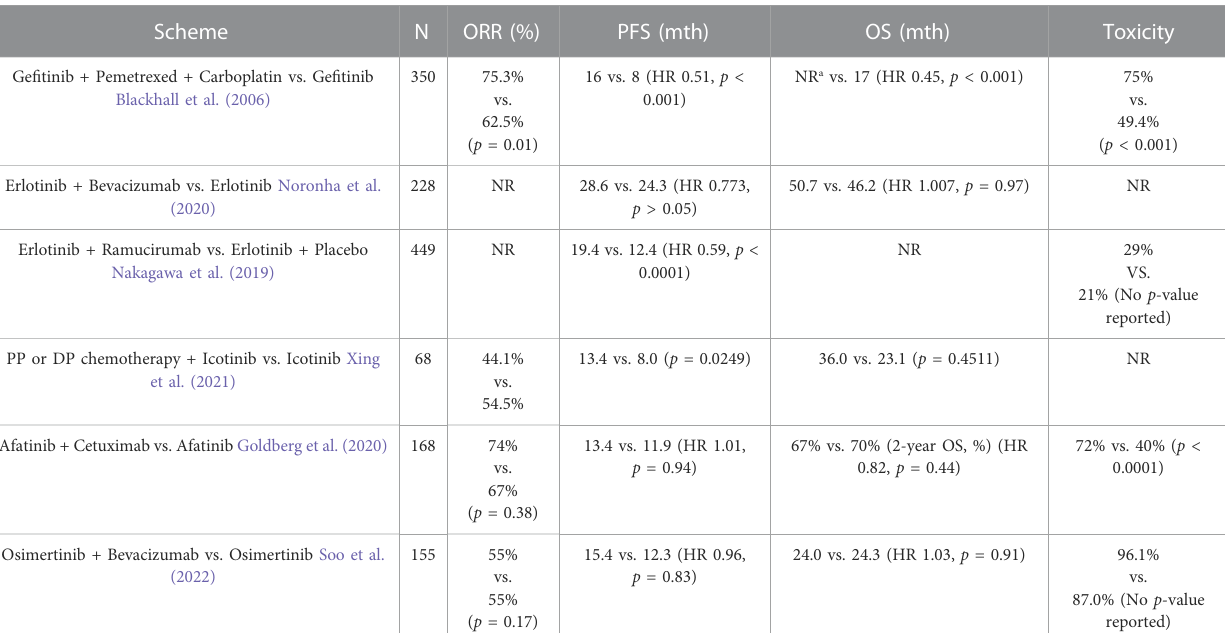
TABLE 1 Clinical study of EGFR-TKIs in synergistic treatment of NSCLC.